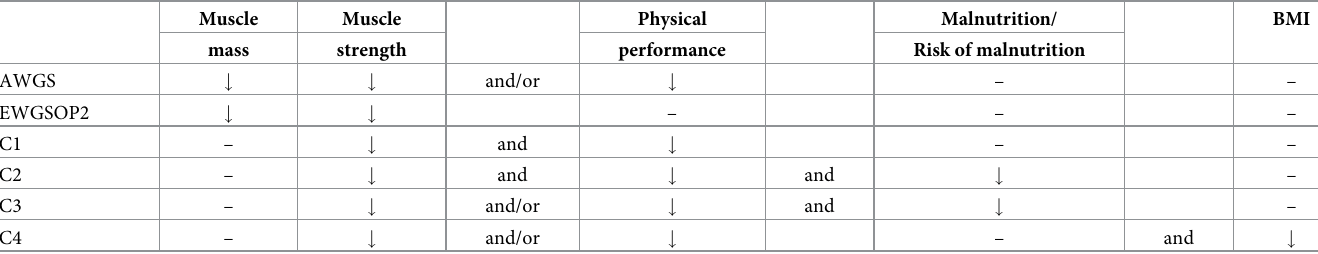
Table 1. Combinations used to diagnose